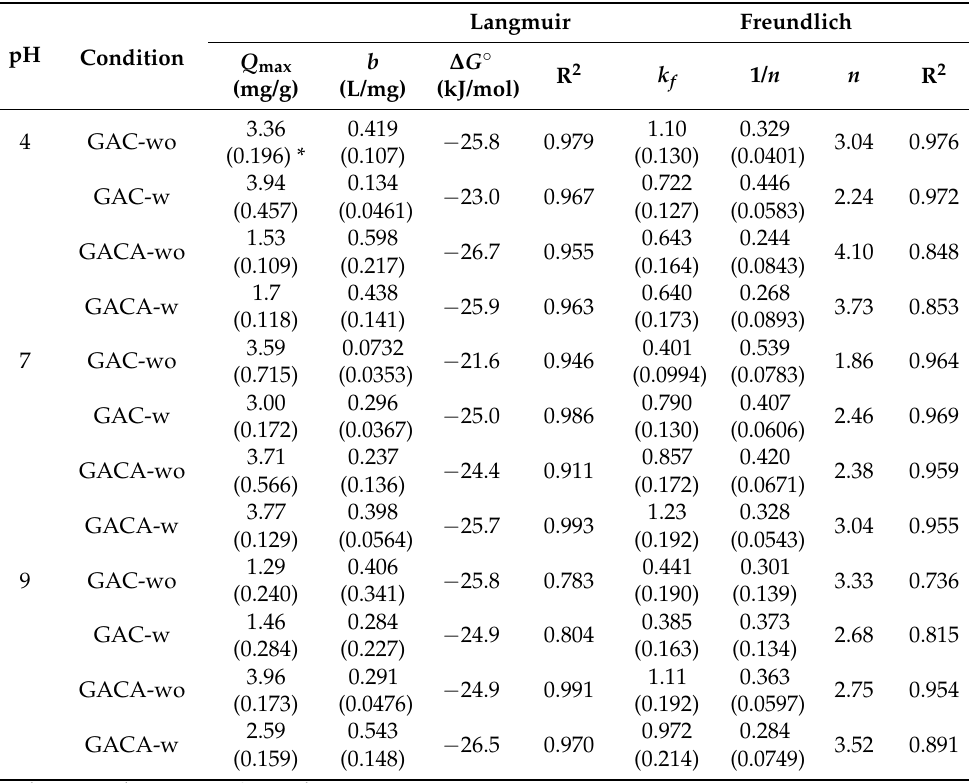
Table 3. Values of the Langmuir and Freundlich parameters for nonlinear